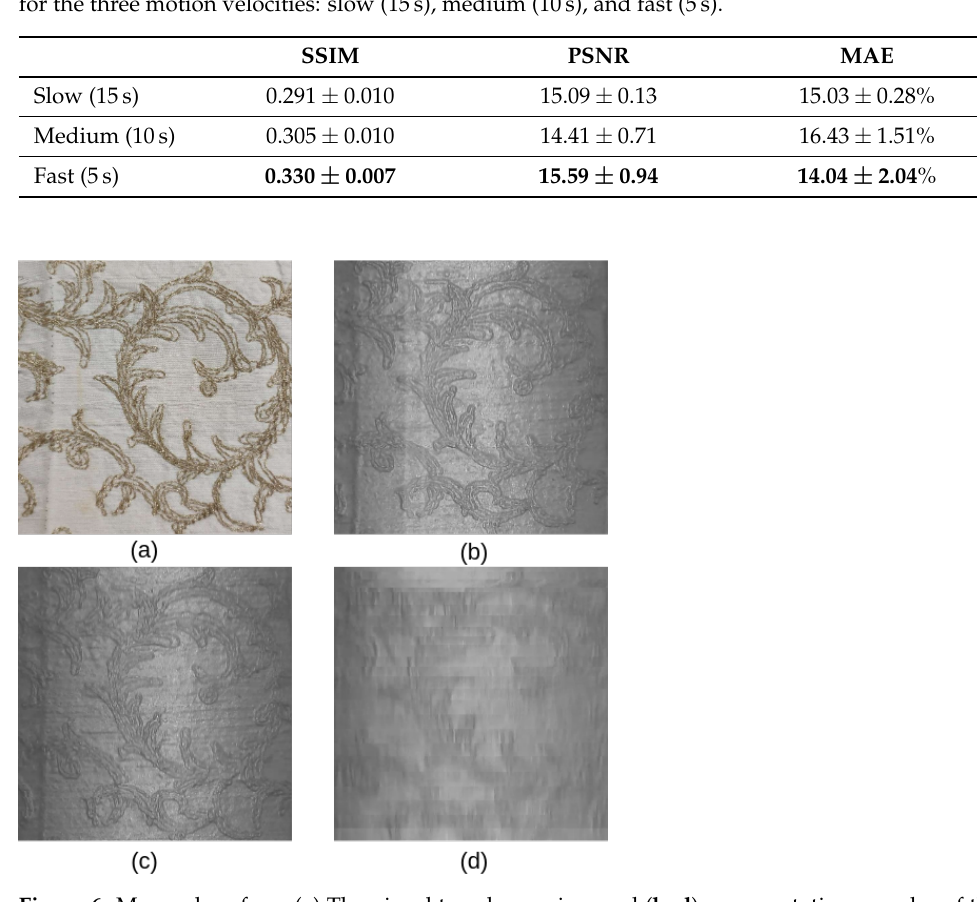
Figure 6. Mapped surface. ( a ) The visual top-down view and ( b – d ) representative samples of the tactile maps obtained with the corresponding slow (15s), medium (10s), and fast (5s)